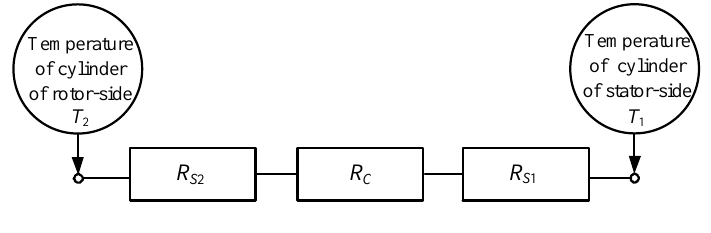
Figure 1. Thermal circuit of the air-gap.